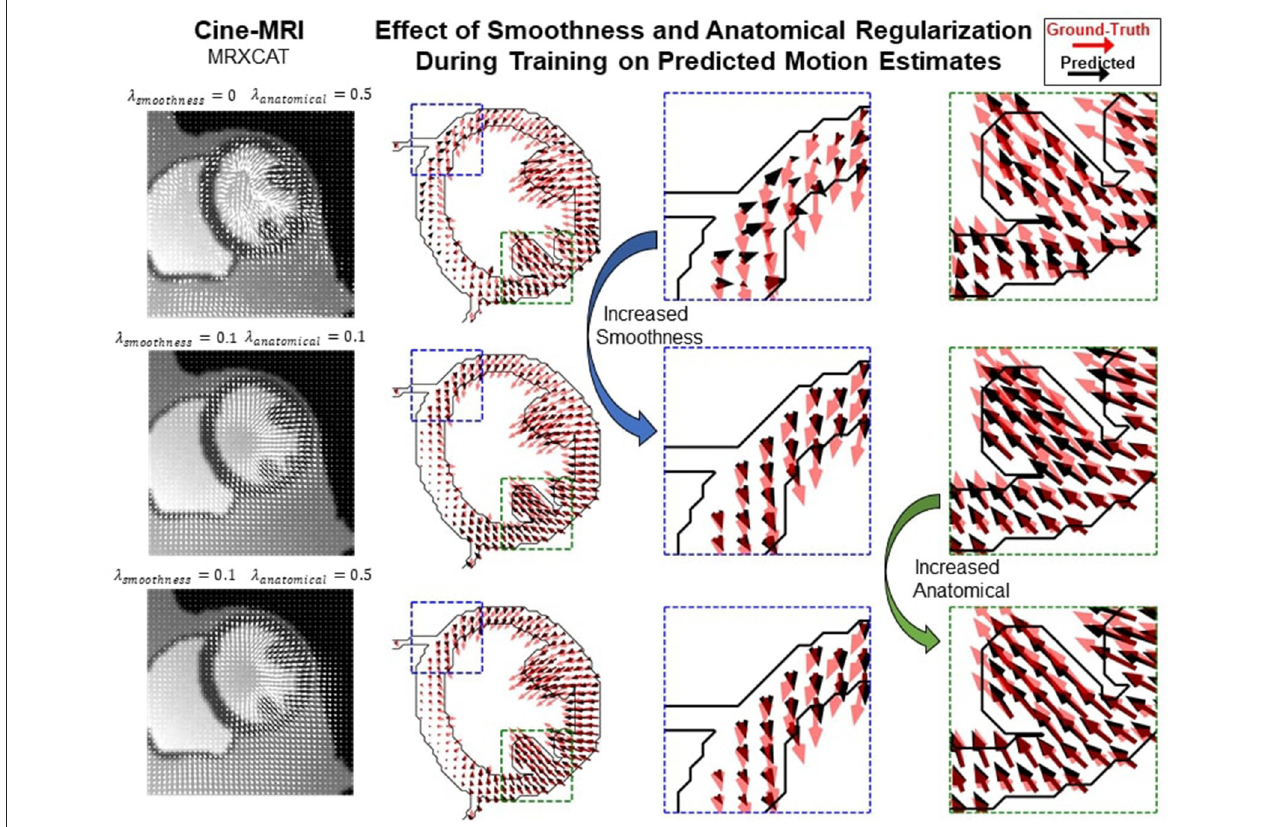
FIGURE 3 | Qualitative effects of smoothing and anatomical regularization on the accuracy of motion estimates on the MRXCAT dataset. First row shows the predicted (black) motion estimates when the anatomical regularization is set to 0.5 and smoothing is set to 0. Relative to the ground-truth (red), these estimates are highly irregular. Increasing (third column) the smoothness to 0.1 and setting anatomical to 0.1 improves the direction of the estimates, but the magnitude is reduced. This is corrected by increasing anatomical regularization to 0.5 (fourth